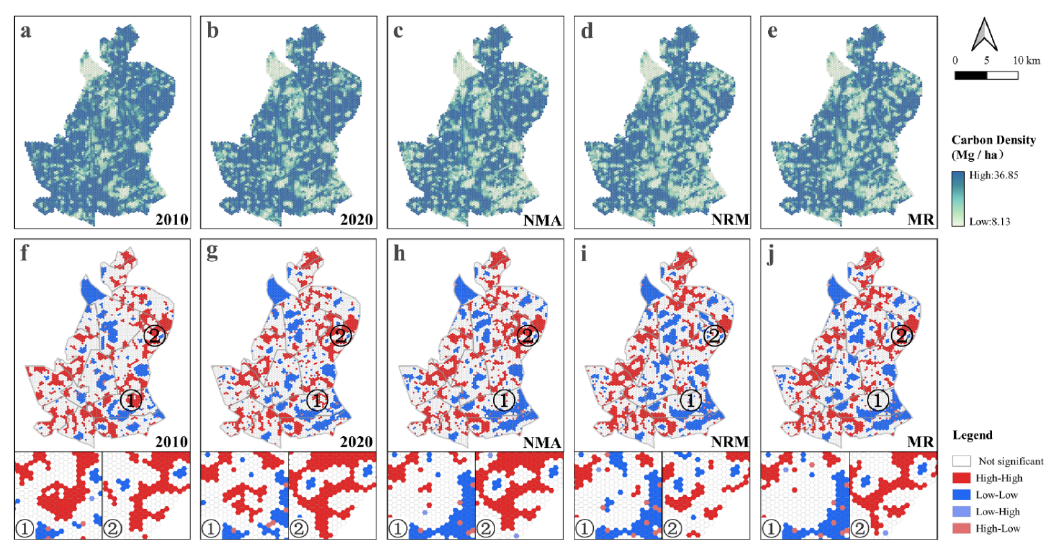
Figure 9. Moran’s I scatterplot.